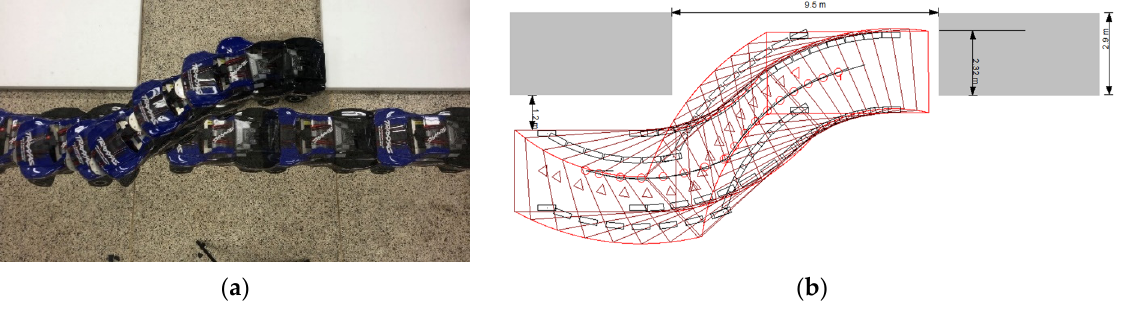
Figure 15. Three-characters ( S + R − L − ) parallel partial parking ( ρ = 0.8): ( a ) Experimental parking test; ( b ) simulated parking path.